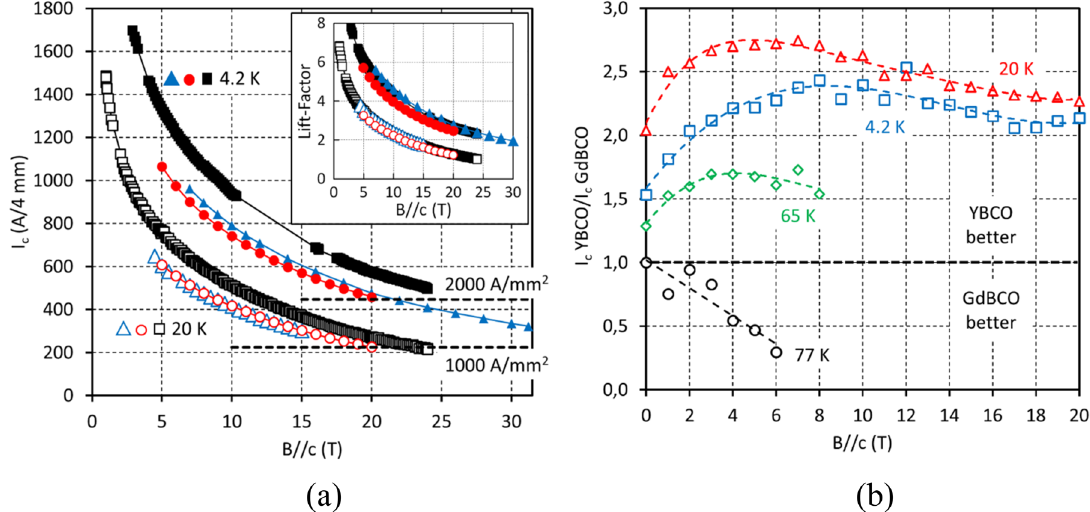
Figure 1. ( a ) Critical current, I c , in magnetic field ( B//c ) at 4.2 and 20 K of three YBCO wire samples measured at University of Geneva (red curves), Tohoku University (black curves) and the NHMFL at Florida State University (blue curves). The 1000 and 2000 A/mm 2 marks for engineering current density, J E , are provided for wire on 40 μm substrate with 5 μm per side stabilising copper layer. In the inset: lift-factors based on 77 K, self-field I c values. Very high values of I c and J E have been achieved. Although the I c values in the three samples are noticeably different, the lift-factor values are very close, manifesting good process reproducibility and predictability of superconducting performance. ( b ) Ratios of I c values of YBCO and GdBCO wires at 4.2, 20, 65, and 77 K in magnetic field. Wherever the ratio is greater than unity, the superconducting performance of YBCO is superior to that of GdBCO and vice versa. Dashed lines on the plot are provided for guidance only.